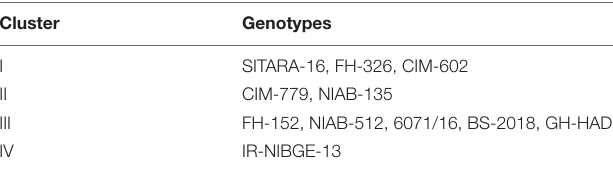
TABLE 13 | Distribution of cotton genotypes in different clusters on the basis of morphophysiological traits.